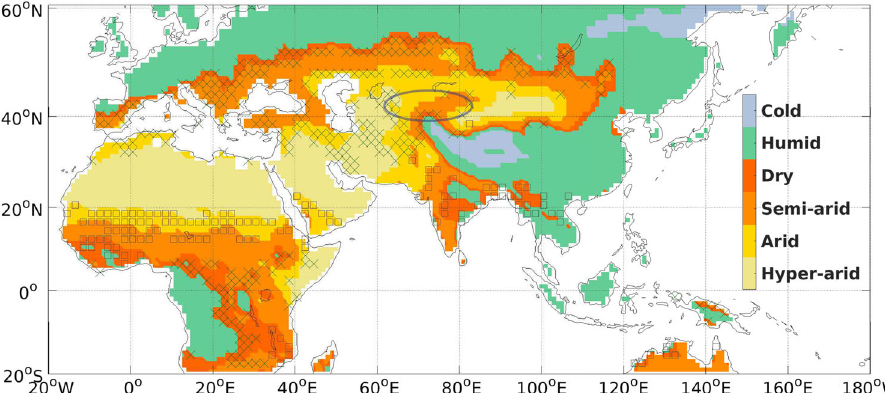
Fig. 5 Change in the aridity pattern in the AWI-ESM low-CO 2 experiment compared to the high-CO 2 experiment. Colors indicate aridity according to the Aridity Index (AI) based on the high-CO 2 experiment (i.e., AWI-ESM simulation with CO 2 at 568 ppmv). The AI is de fi ned as the ratio between annual mean precipitation and potential evaporation: Hyper-arid (AI < 0.05), Arid (0.05 < AI < 0.2), Semi-arid (0.2 < AI < 0.5), Dry (0.5 < AI < 0.65), Humid (AI > 0.65), Cold (yearly potential evaporation <400mm). The blue crosses mark regions where the climate type changed to more humid conditions in the low-CO 2 experiment compared to the high-CO 2 experiment. The black squares mark regions where the climate type changed towards more arid conditions in the low-CO 2 experiment. These dry and wet transition regions are identi fi ed based on the AI index. Overall, less arid conditions are observed over Central Asia in the low-CO 2 experiment. The blue oval indicates the approximate location of the Tarim